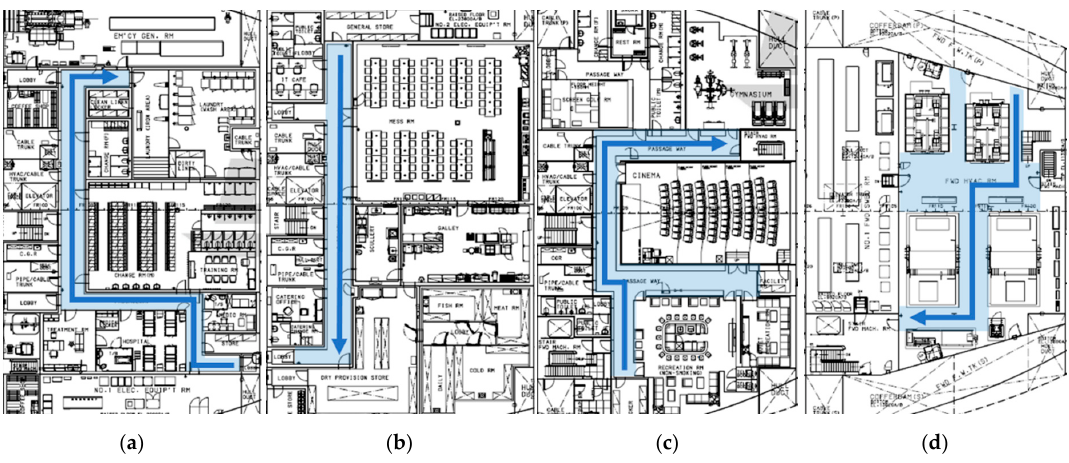
Figure 10. Collected radio maps for each deck: ( a ) main deck; ( b ) A deck; ( c ) first deck; ( d ) second deck.